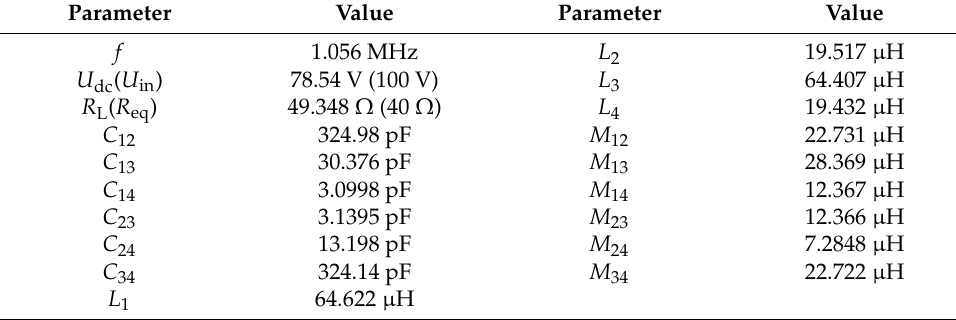
Table 3. Circuit simulation parameters.